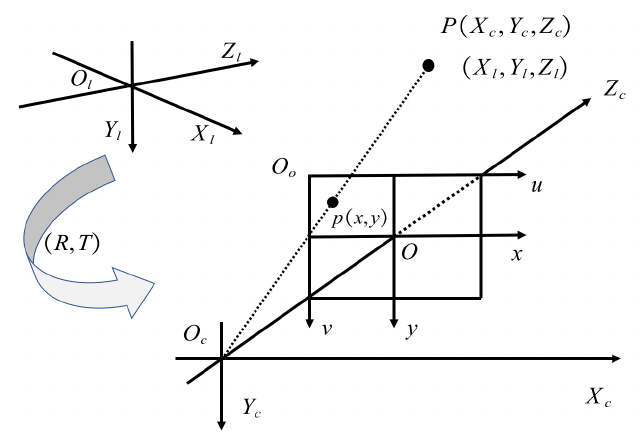
Figure 1. Calibration model of LiDAR–camera system and projection model of the